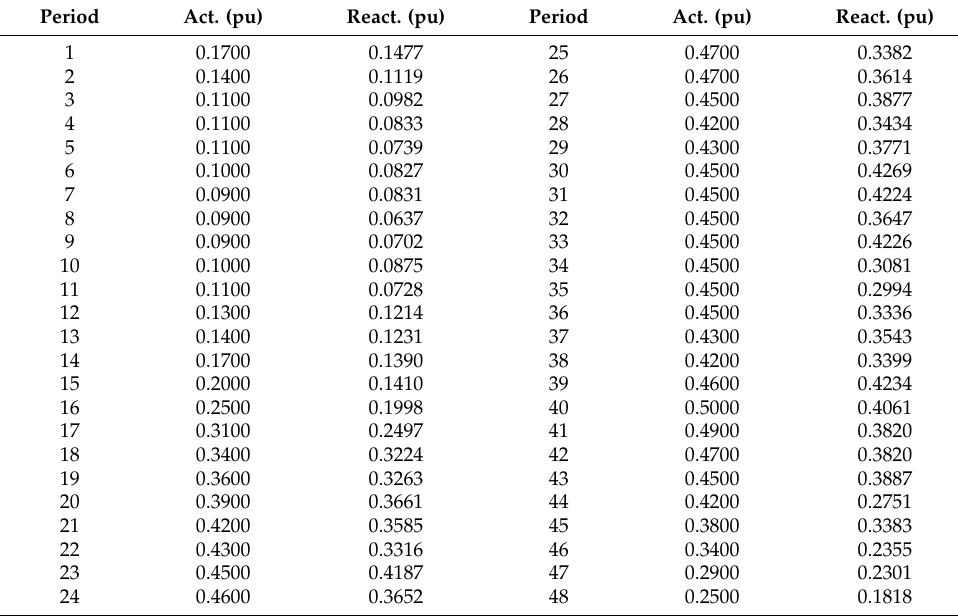
Table 3. Daily active and reactive demand profiles.